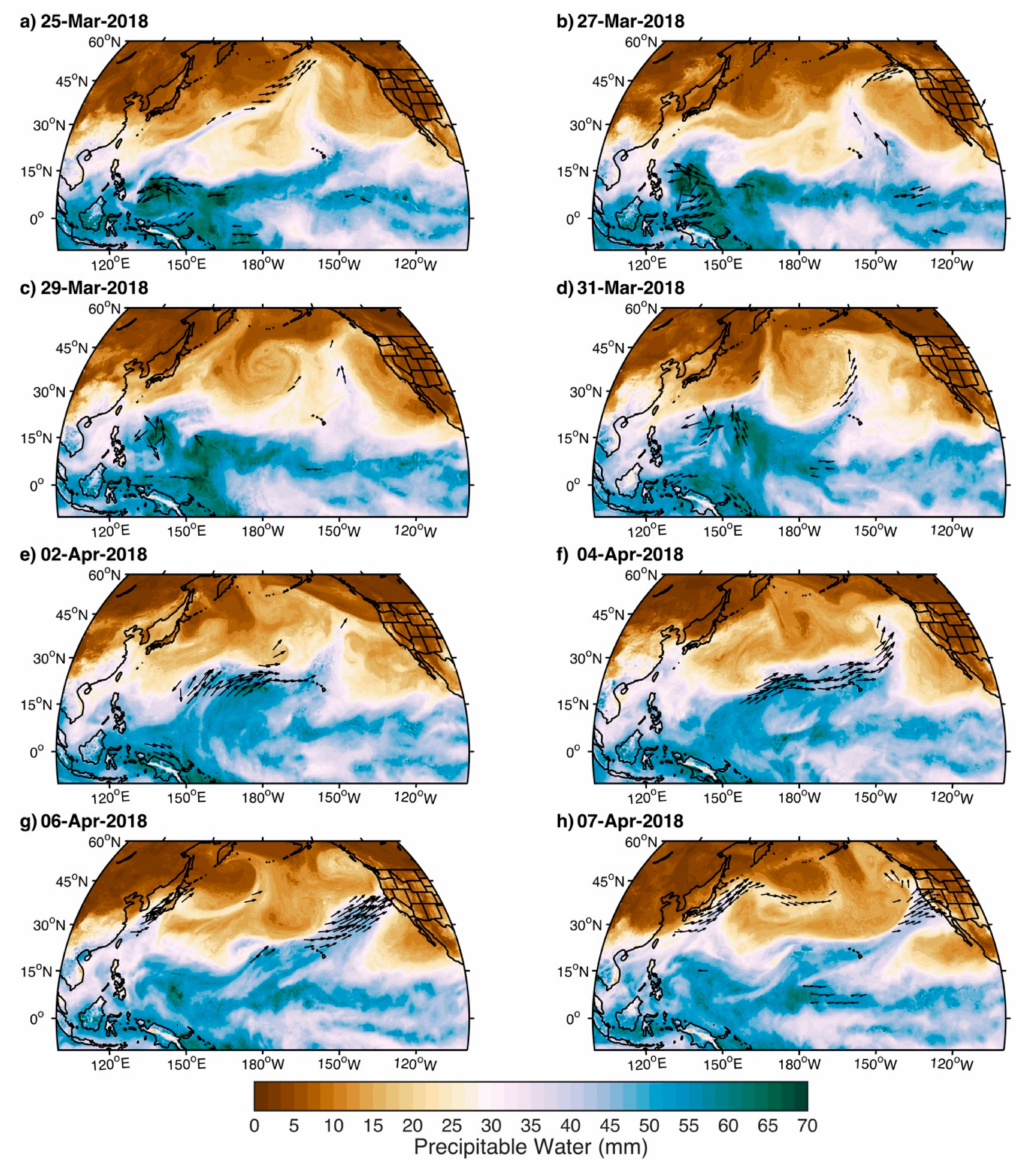
Figure 3. Morphed Integrated Microwave Imagery at CIMMS (Cooperative Institute for Meteorological Satellite Studies)-Total Precipitable Water version 2 (MIMIC-TPW2; [18]) total precipitable water (mm; filled contours) observations and MERRA (Modern-Era Retrospective analysis for Research and Applications) integrated vapor transport (IVT; kg m − 1 s − 1 ; black vectors) for: ( a ) 25 March 2018; ( b ) 27 March 2018; ( c ) 29 March 2018; ( d ) 31 March 2018; ( e ) 2 April 2018; ( f ) 4 April 2018; ( g ) 6 April 2018; ( h ) 7 April 2018. Only IVT vectors exceeding 500 kg m − 1 s − 1 are plotted with the largest vector equal to 1500 kg m − 1 s − 1 . For clarity, only every fifth IVT vector is